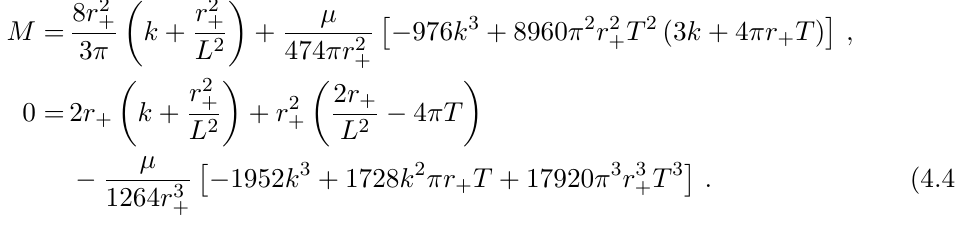
0 as M 0. In both cases, the red curve → → 5 10 . Note that in these plots µ c − − | |